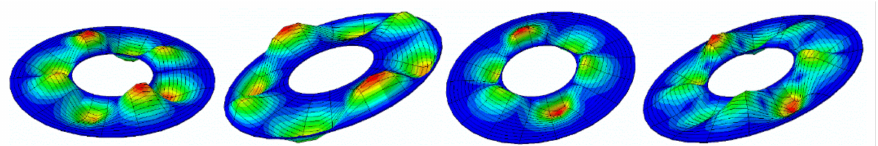
Figure 7. Forms of buckling modes for plate with thermal orthotropic.